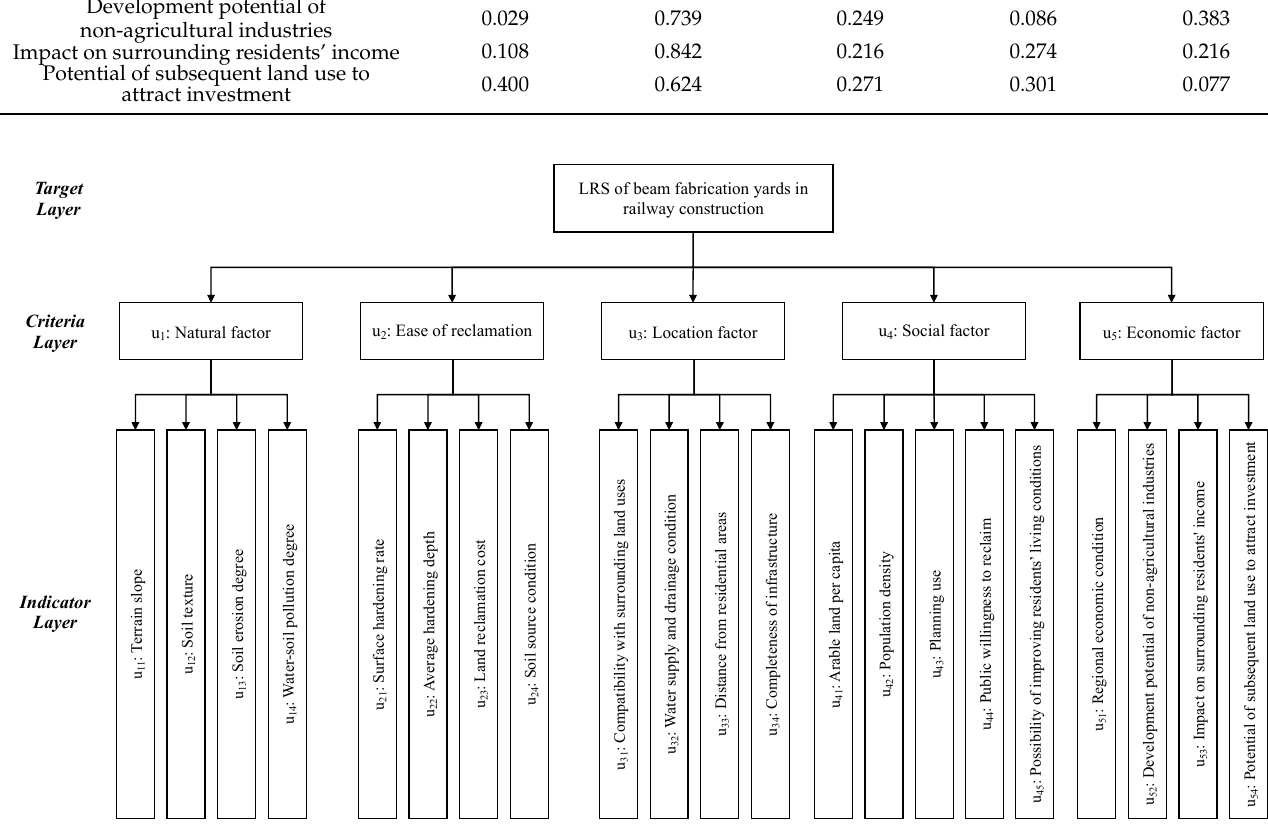
Figure 2. LRS evaluation indicator system of BFSY in railway construction.